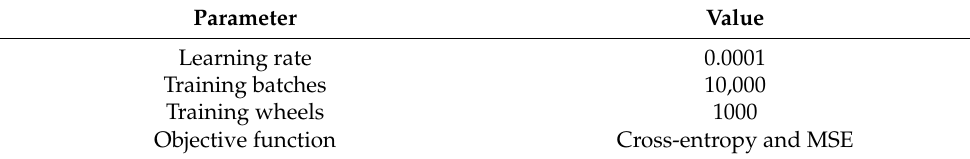
Table 1. The model super